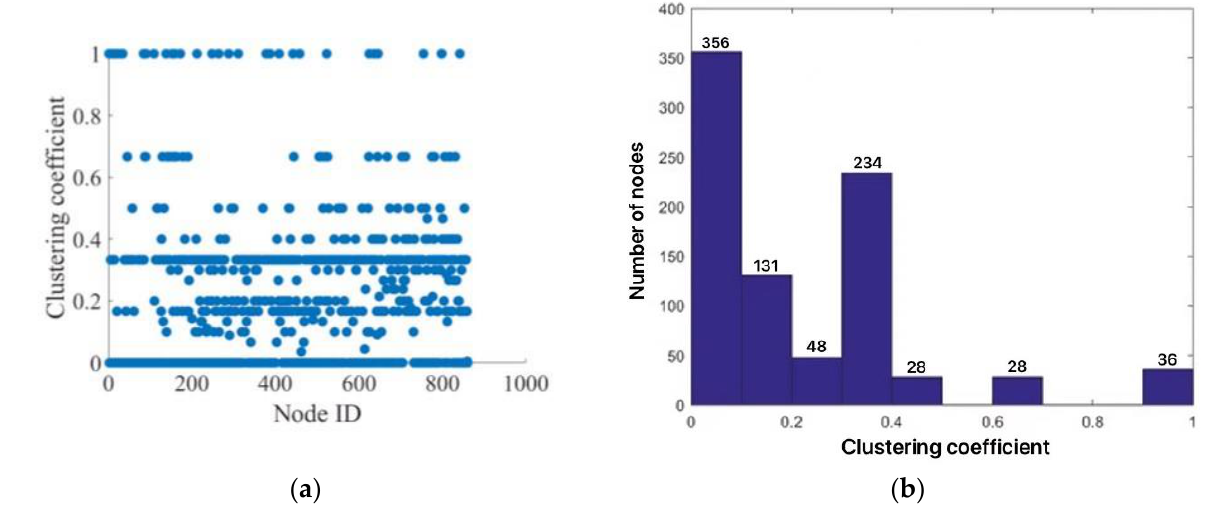
Figure 9. ( a ) Distribution of clustering coefficient; ( b ) clustering coefficient distribution histogram.